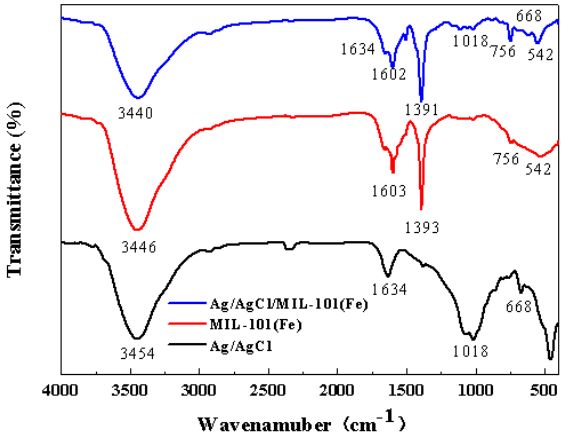
Figure 3. FTIR spectra of pure Ag / AgCl, MIL-101(Fe) and Ag / AgCl / MIL-101(Fe).